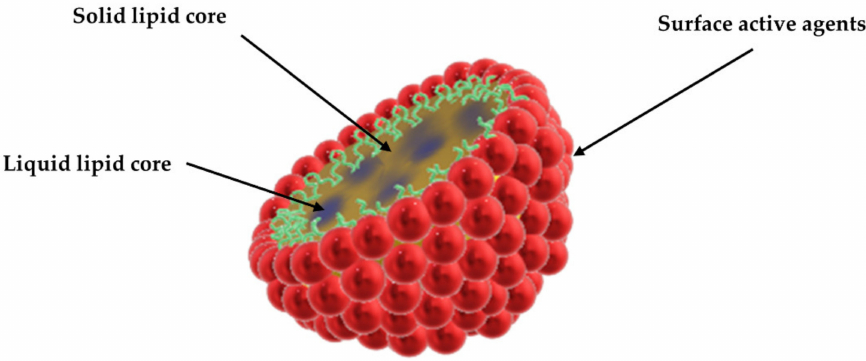
Figure 3. Nanostructured lipid carriers